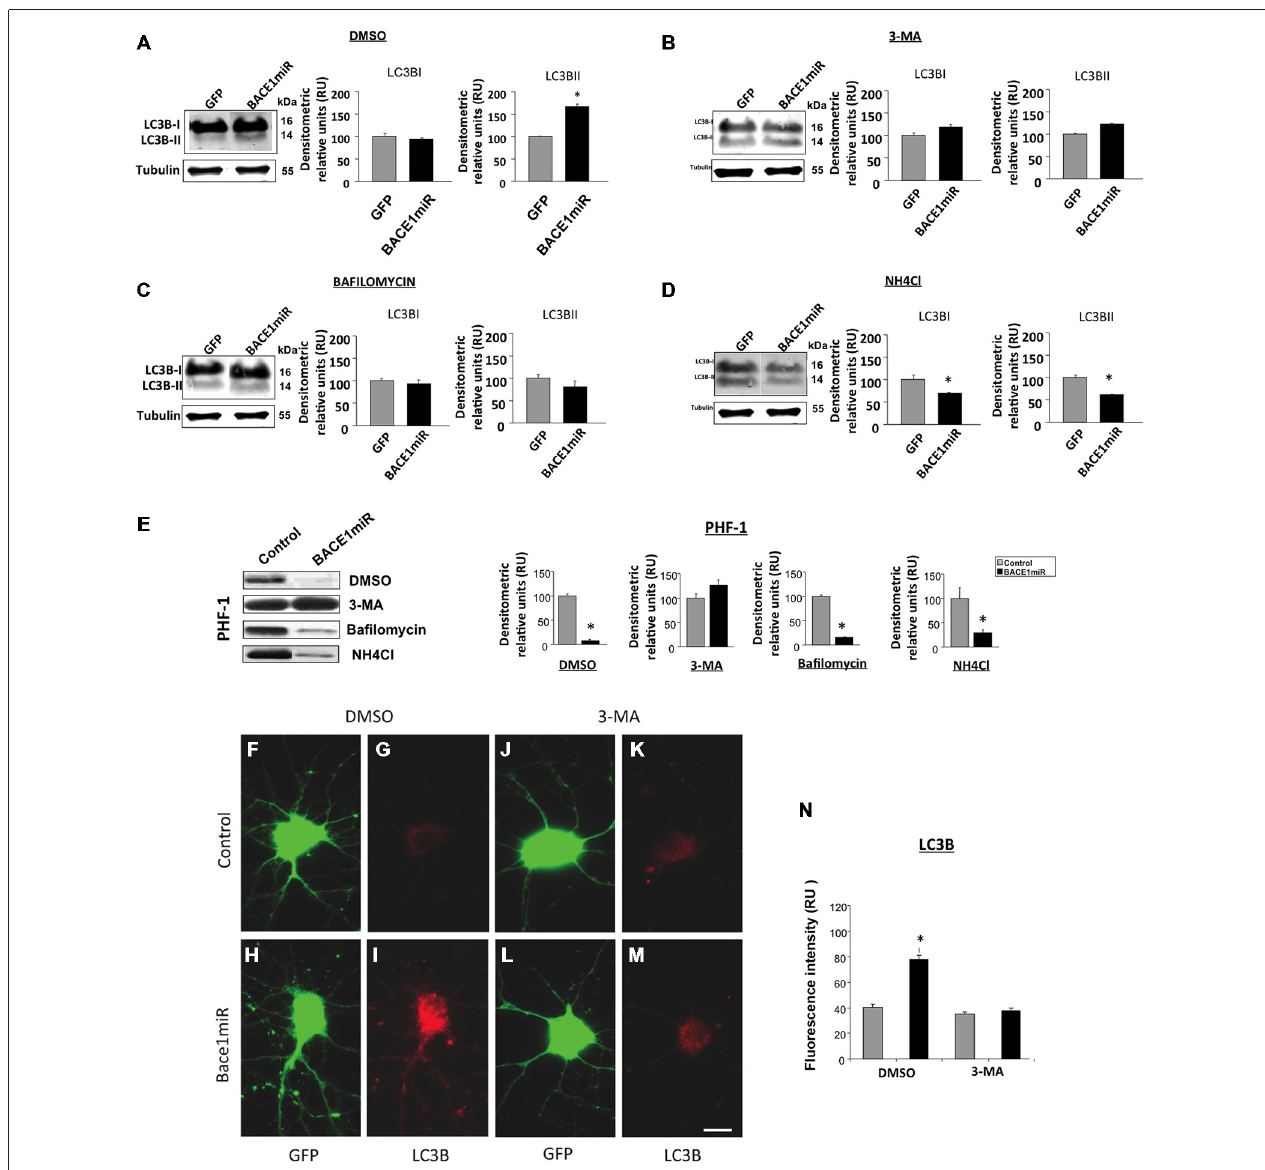
FIGURE 6 | BACE1miR reduces the level of hyperphosphorylated tau, and this effect is blocked by 3-MA. Primary cortical cultures were transduced with AAV2/5-BACE1miR or AAV2/5-GFP at DIV5 for 7 days. The neurons were exposed to autophagy inhibitors, including 3-methyladenine (10 mM), bafilomycin (100 nM), ammonium chloride (NH 4 Cl, 20 mM) or DMSO for 24 h. (A) Representative bands and quantification of the levels of LC-3B I and II proteins from neurons transduced with AAV2/5-BACE1miR or AAV2/5-GFP and treated with DMSO, (B) 3-methyladenine (10 mM), (C) bafilomycin (100 nM), and (D) ammonium chloride (NH 4 Cl, 20 mM). RU = relative units, n = 3, ∗ p < 0.05. (E) Representative Western blots for PHF-1 from neurons transduced with AAV2/5-GFP or AAV2/5-BACE1miR. β III-tubulin was used as a loading control. Densitometric quantification was performed; RU = relative units. n = 3, ∗ p < 0.05. (F,J) GFP expression in hippocampal neurons transduced with AAV2/5-GFP (control). (H,L) GFP expression in hippocampal neurons transduced with AAV2/5-BACE1miR (BACE1miR). (G,K) LC3B immunofluorescence in neurons transduced with AAV2/5-GFP (control). (I,M) LC3B immunofluorescence in neurons transduced with AAV2/5-BACE1miR (BACE1miR). (F–I) Neurons were treated with DMSO as a control; (J–M) neurons were treated with 3-methyladenine (10 mM). Green: GFP fluorescence, red: Alexa 594 fluorescence. 60X magnification; scale bar: 20 µ m. n = 3. (N) Quantification of the LC3B fluorescence intensity using Scope-Pro image software (Media Cybernetics) in neurons transduced with AAV2/5-BACE1miR or AAV2/5-GFP and treated with 3-methyladenine (10 mM) or DMSO; RU = relative units, n = 3, ∗ p < 0.05.